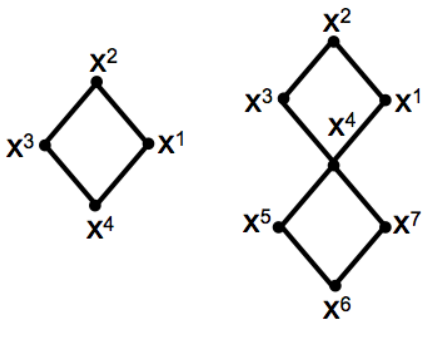
Figure 1. The pinned necklace reduces to the consideration of two necklaces sharing the pinned